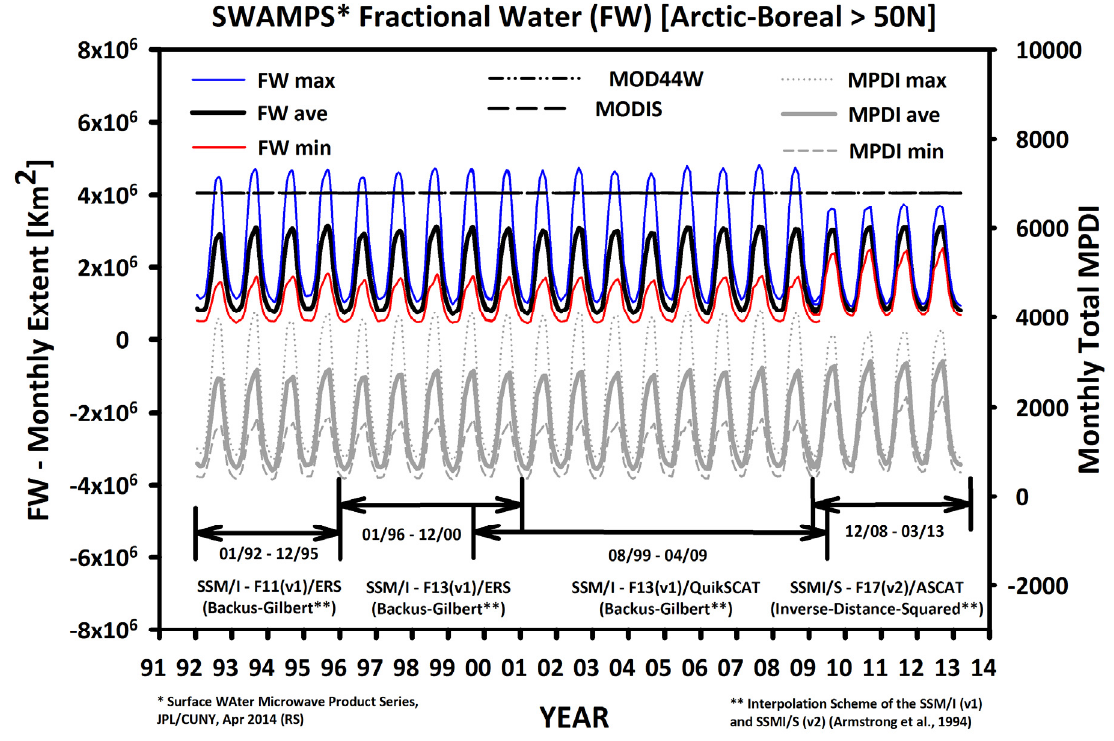
Figure 8. Seasonal progression of monthly FW extents (km 2 ) from SWAMPS and total Microwave Polarization Difference Index (MPDI) in the Arctic-Boreal domain (>50°N) as generated from monthly maximum (FW max , MPDI max ) average (FW ave , MPDI ave ) and minimum (FW min , MPDI min ) for the study period (1992–2013). The Arctic-Boreal FW extent from static measures of FW from the MOD44W and MODIS including wetlands products are shown for comparison. Note that FW has been plotted from all record periods including duplicate measurements taken during period overlap.